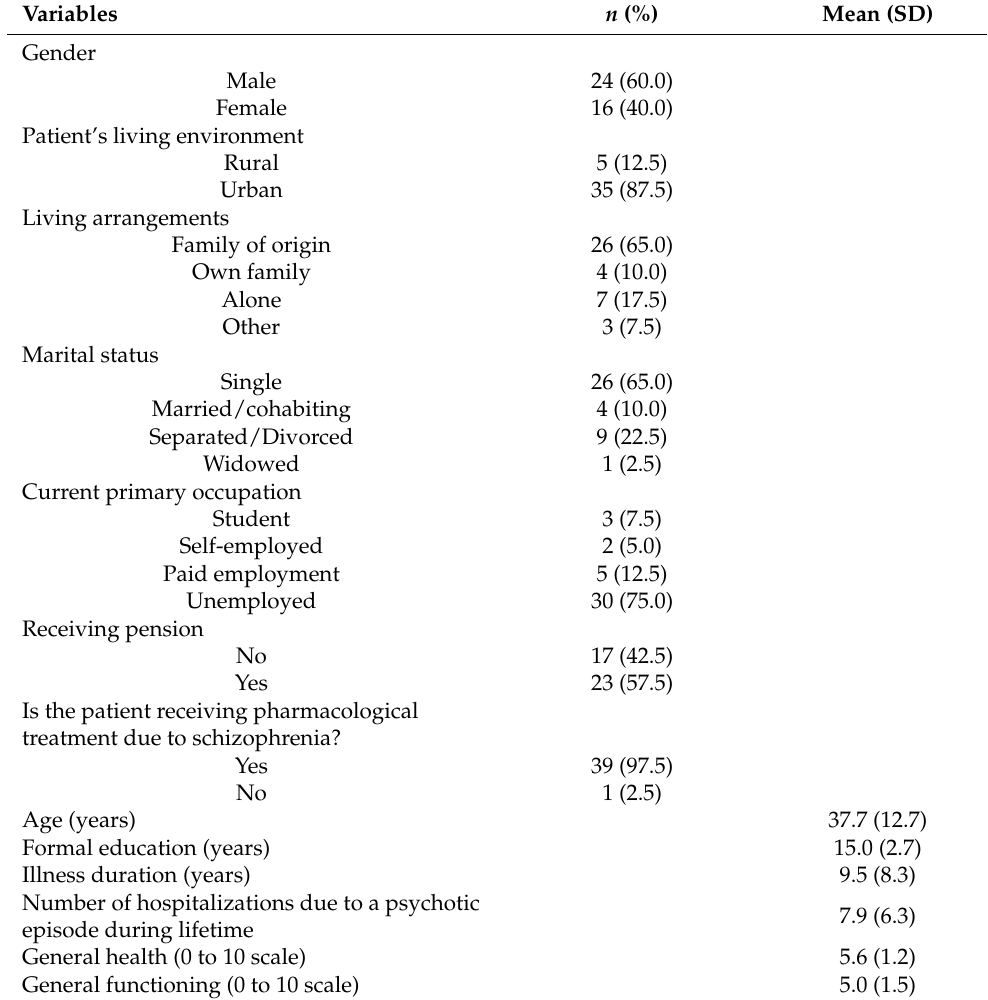
Table 1. Socio-demographic and clinical variables of participants ( n =